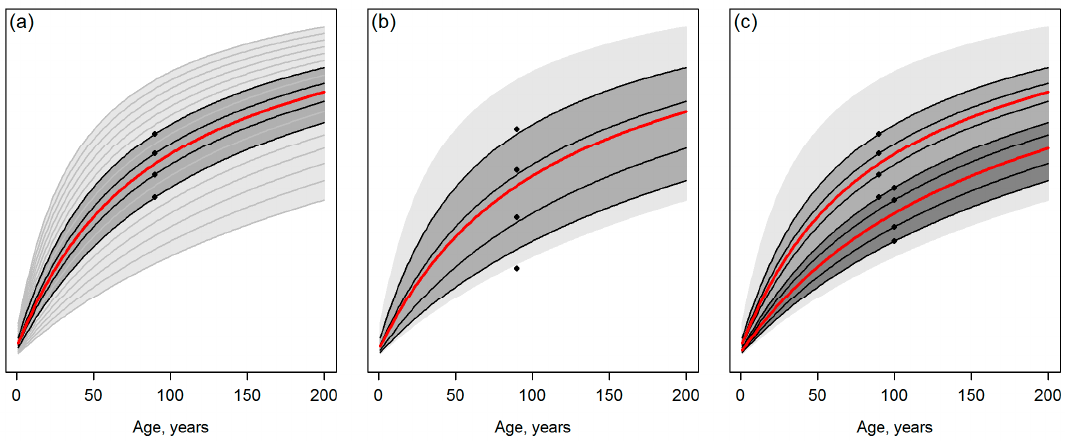
Figure 1. In the template matching [1], the future growth trajectory (red line) is determined as the weighted mean of the most suitable template trajectories (black lines) selected by matching with observations (black dots); ( a ) shows the candidate templates as gray curves and the space bounded by them with light gray filling that recurs in the sub-figures. The darker gray fillings indicate the sub-space from which the final template is selected. Note that the total sub-space area and the final, averaged growth trajectory selected according to Tompalski et al. [1] would be equal between sub-figures ( b , c ), showing examples of ( b ) erroneous (single-date) observations and ( c ) error-free, multi-date data.